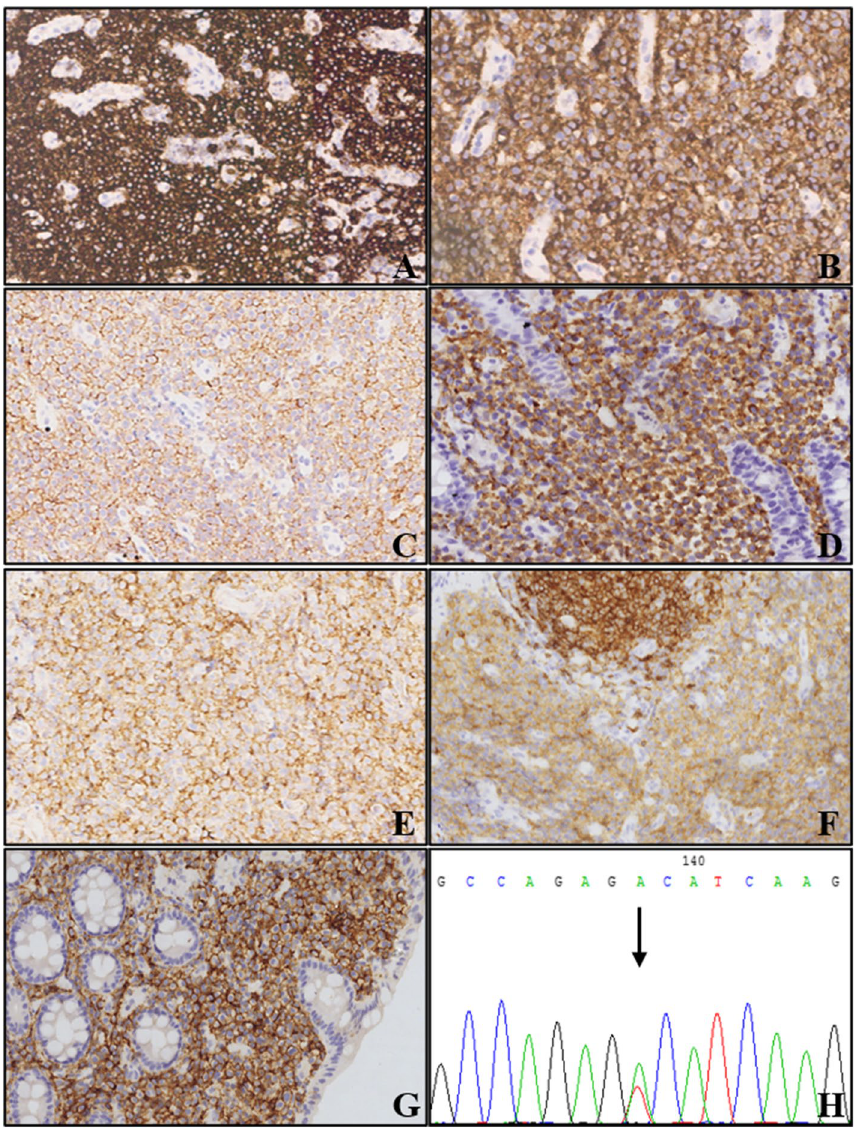
Fig. 2 Immunohistochemical and molecular pathological findings of the patient with systemic mastocytosis. Diffuse expression of CD45 ( A ), CD117 ( B ), CD25 ( C ), CD68 ( D ), CD123 ( E ), CD4 ( F ), and CD56 ( G ) in mast cells (immunohistochemistry, (c.2447A > T, p.D816V) in the exon 17 of KIT